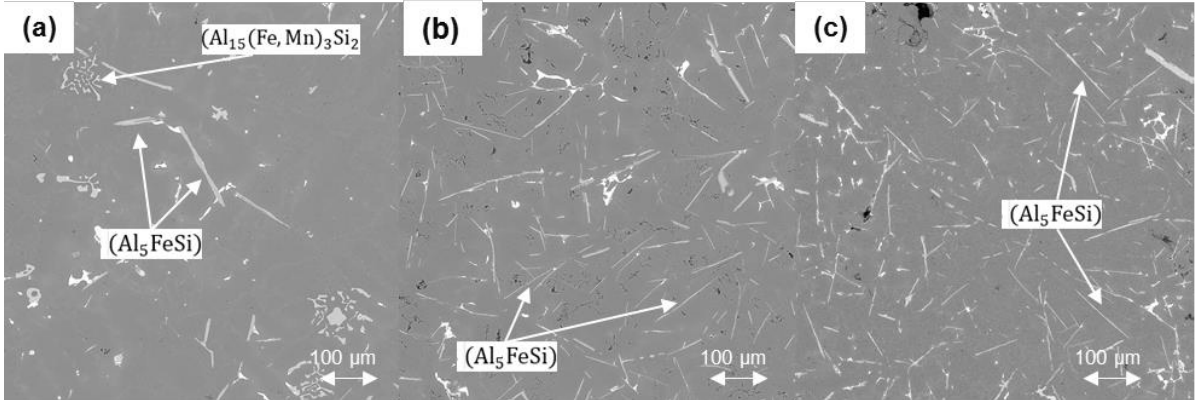
Figure 5. Cross section of SEM images ( a ) cast condition without grain refiner; ( b ) grain refiner Al5Ti2B; ( c ) grain refiner Al5Ti1B—200 × .